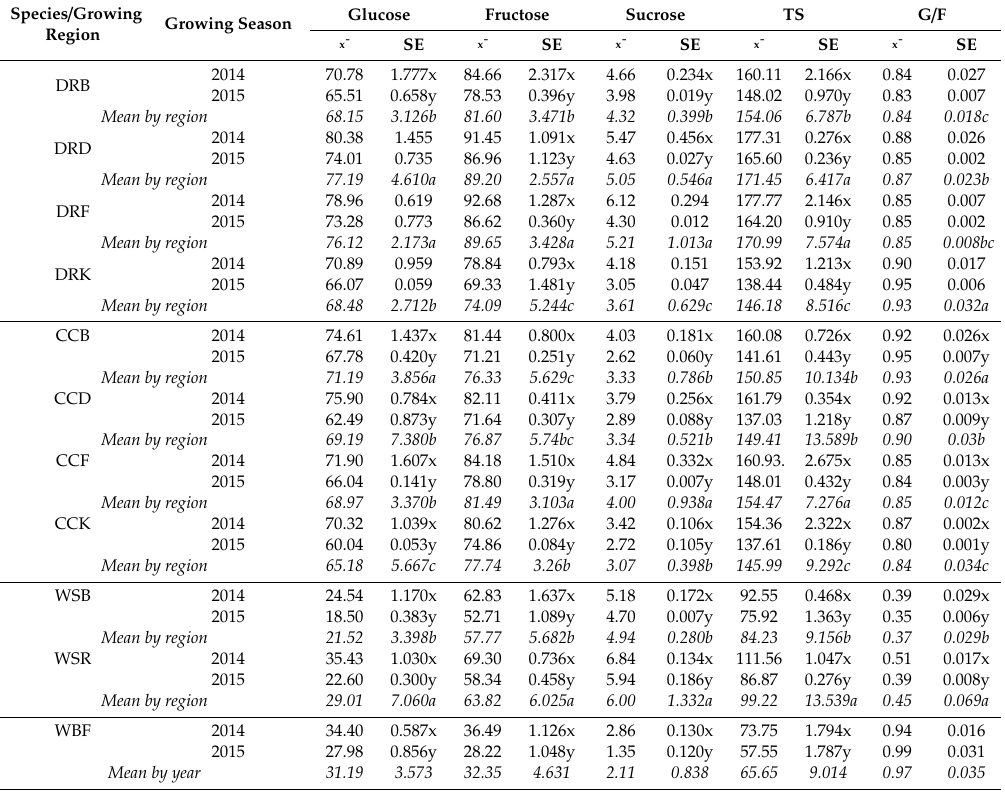
Table 3. Average content of individual sugars, total sugars (TS) and glucose/fructose ratio (G/F) ± SE in analyzed wild fruit species (g kg − 1 FM (fresh mass))*. Species/ Growing